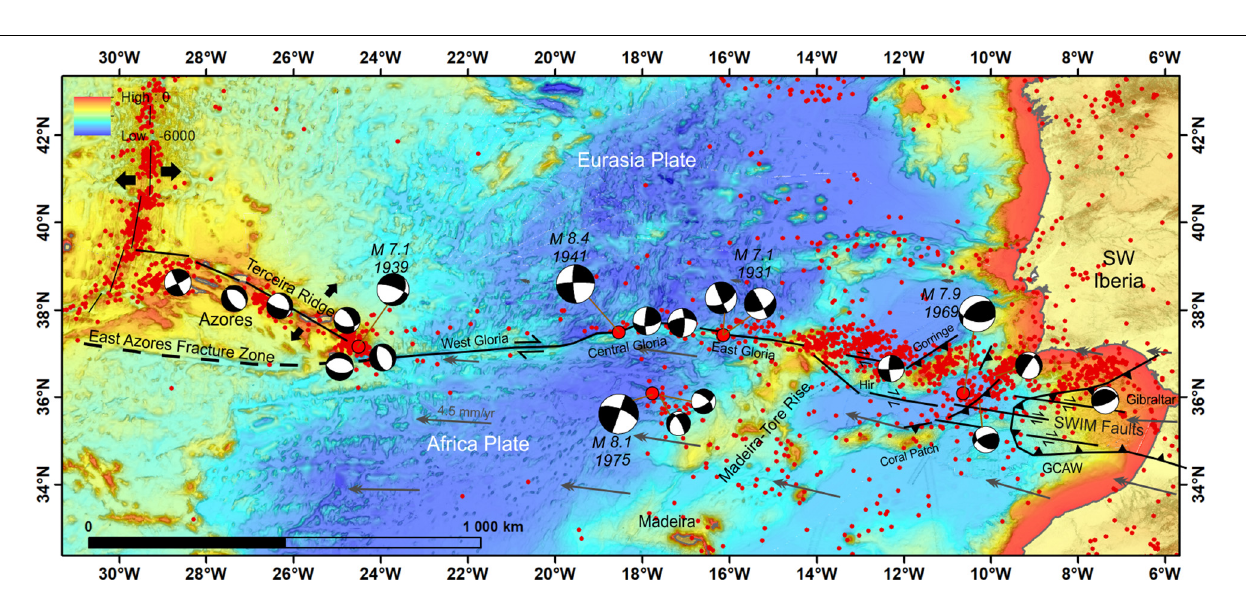
Frontiers in Earth Science |